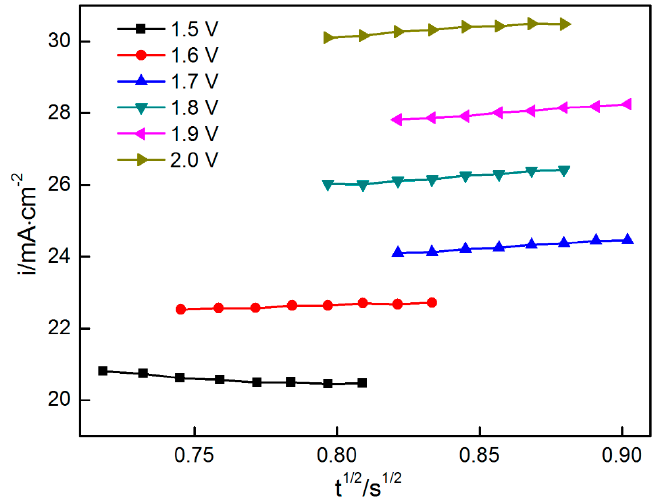
Figure 5. i – t 1/2 relationship when the potential was changed from 1.5 V to 2.0 V.